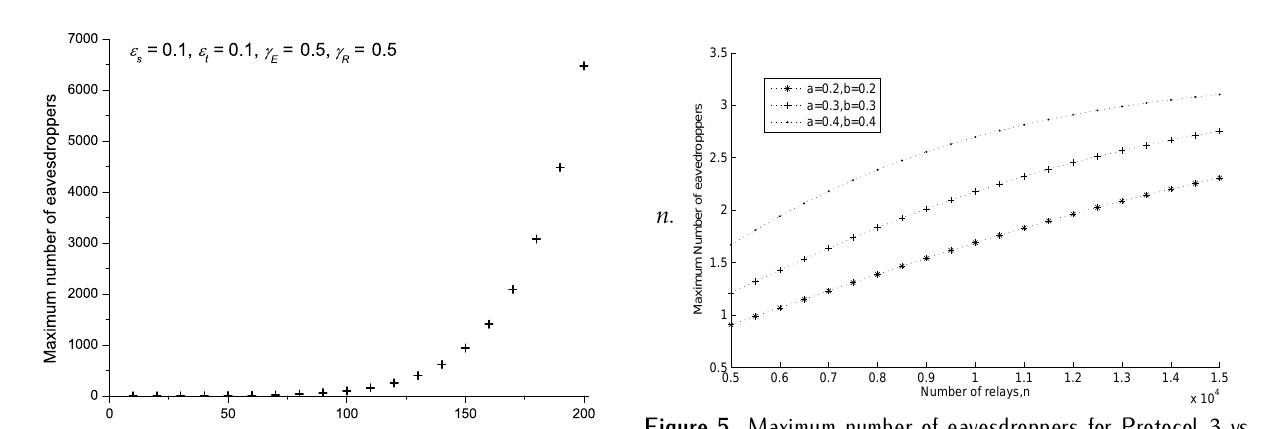
Figure 5. Maximum number of eavesdroppers for Protocol 3 vs.